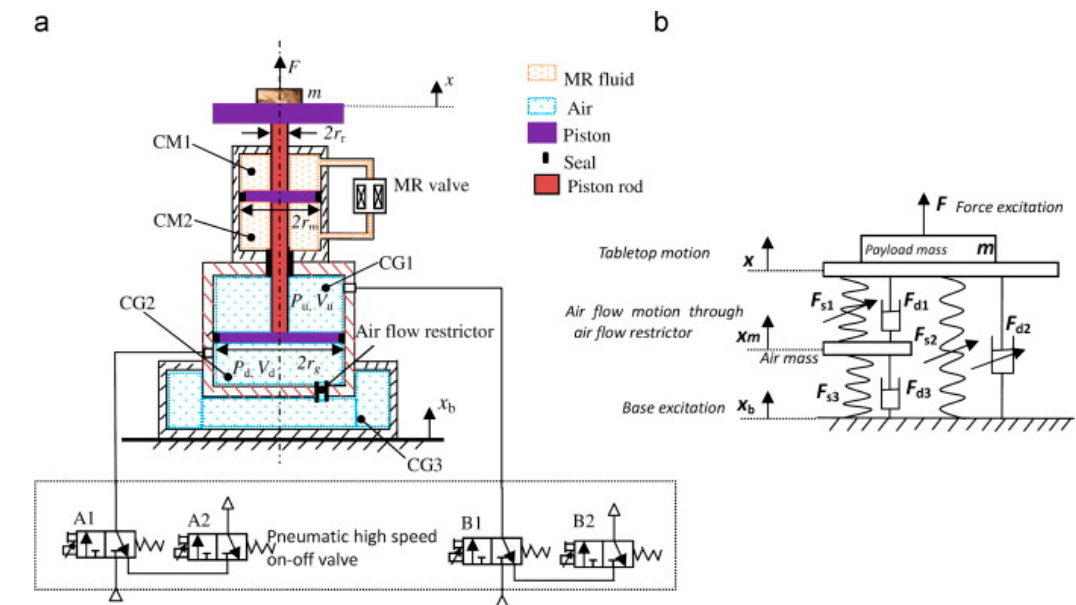
Figure 9. ( a ) The schematic structure of the magneto-rheological fluid embedded pneumatic vibration isolator (MrEPI) and ( b ) its equivalent mechanical system. Reprinted from [26], © 2015 with permission from Elsevier.